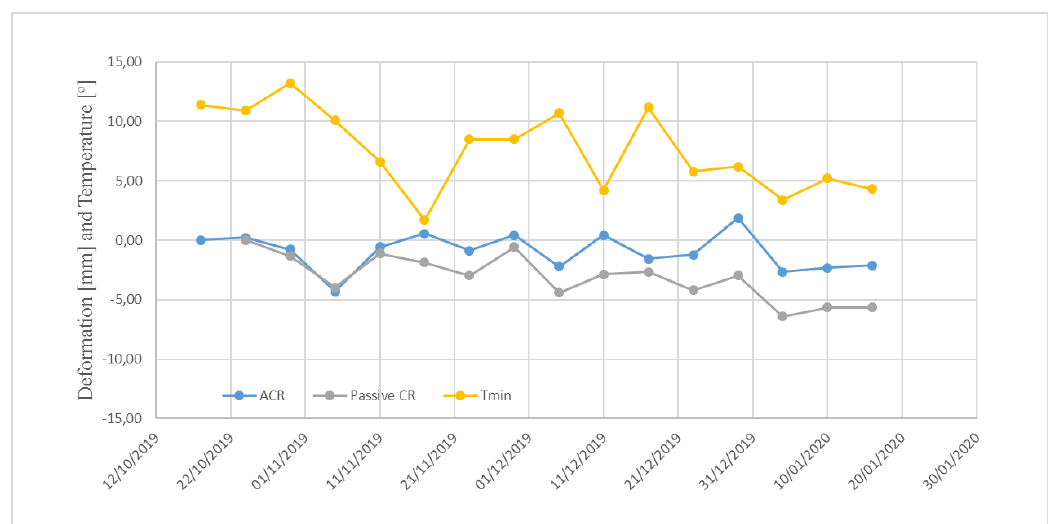
Figure 6. Deformation time series of an AR (ACR, blue line) and a PCR (grey line). Temperature of the acquisition dates of the used Sentinel-1 images (yellow